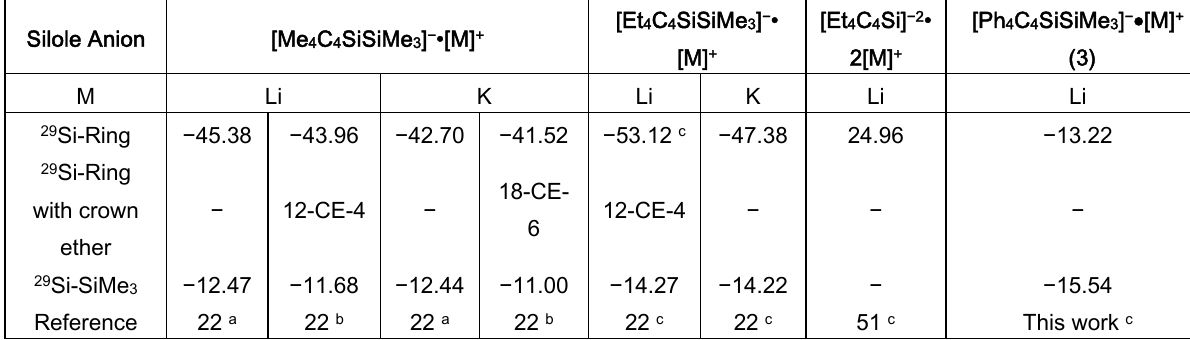
Table 3. 29 Si-NMR chemical shifts of silole anions and